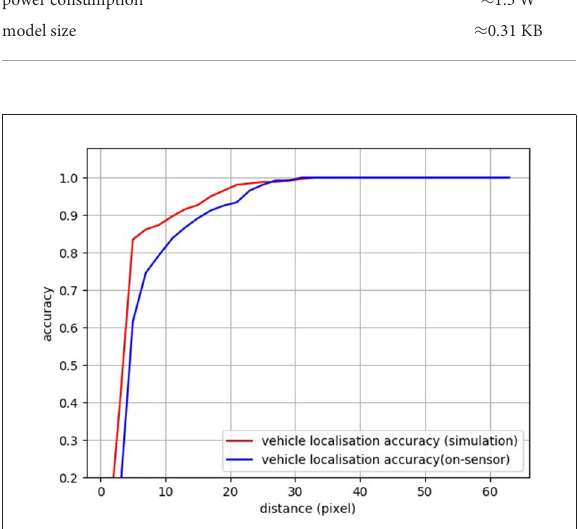
FIGURE14 Performance comparison between simulation and on the sensor for localization